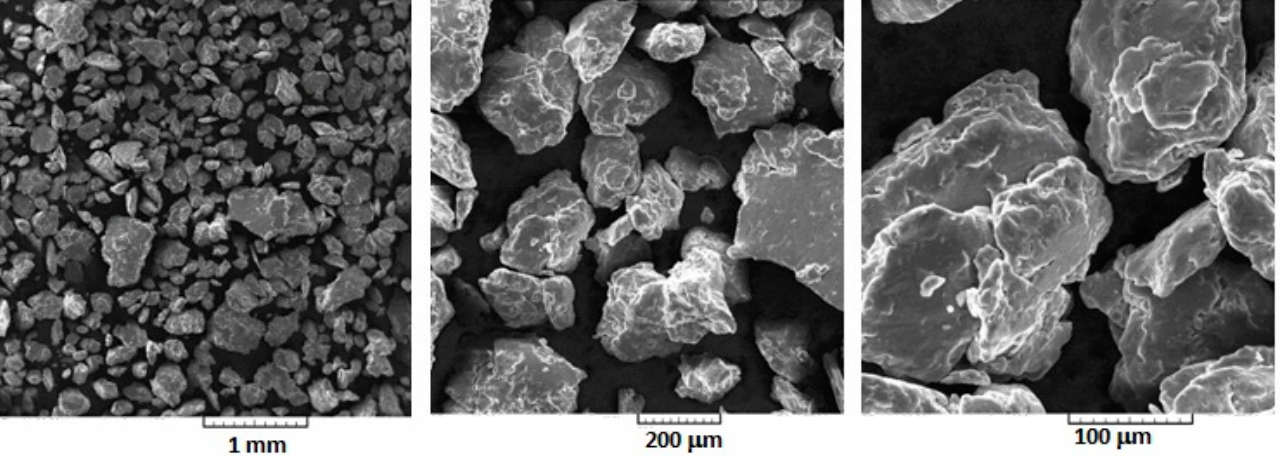
Figure 8. The Mg-10Zn-0.8Ca-0.5Zr (wt.%) alloy-powder processed by mechanical alloying with 300 rpm/16 h/10:1.